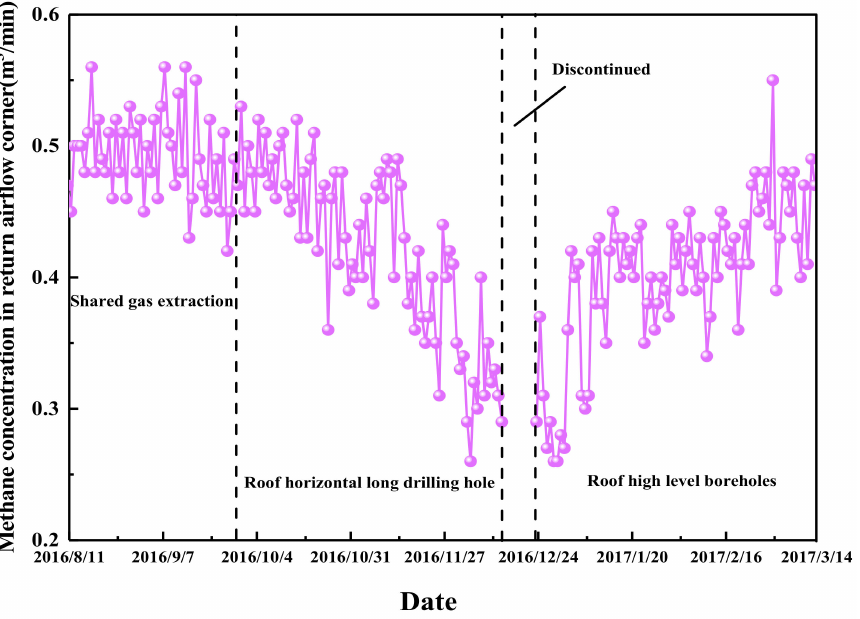
Figure 15. Changes in the concentration of CH 4 in the return airflow corner over